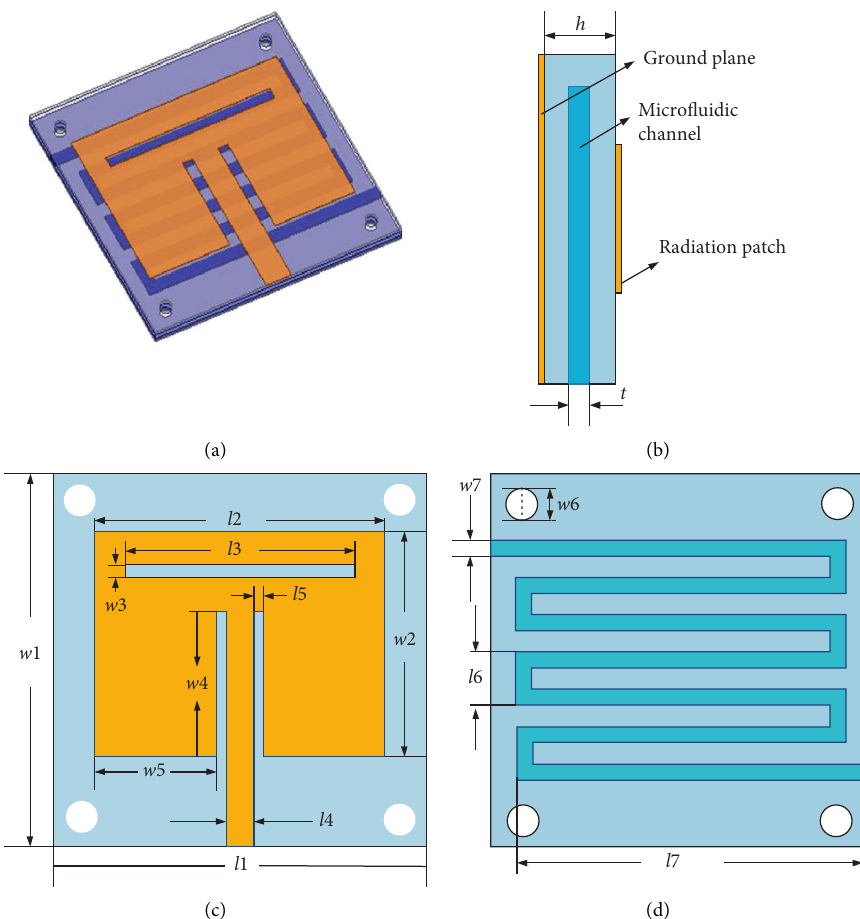
Figure 1: Geometry of the proposed antenna: (a) 3D view; (b) side view; (c) the radiation patch; (d) the microfluidic